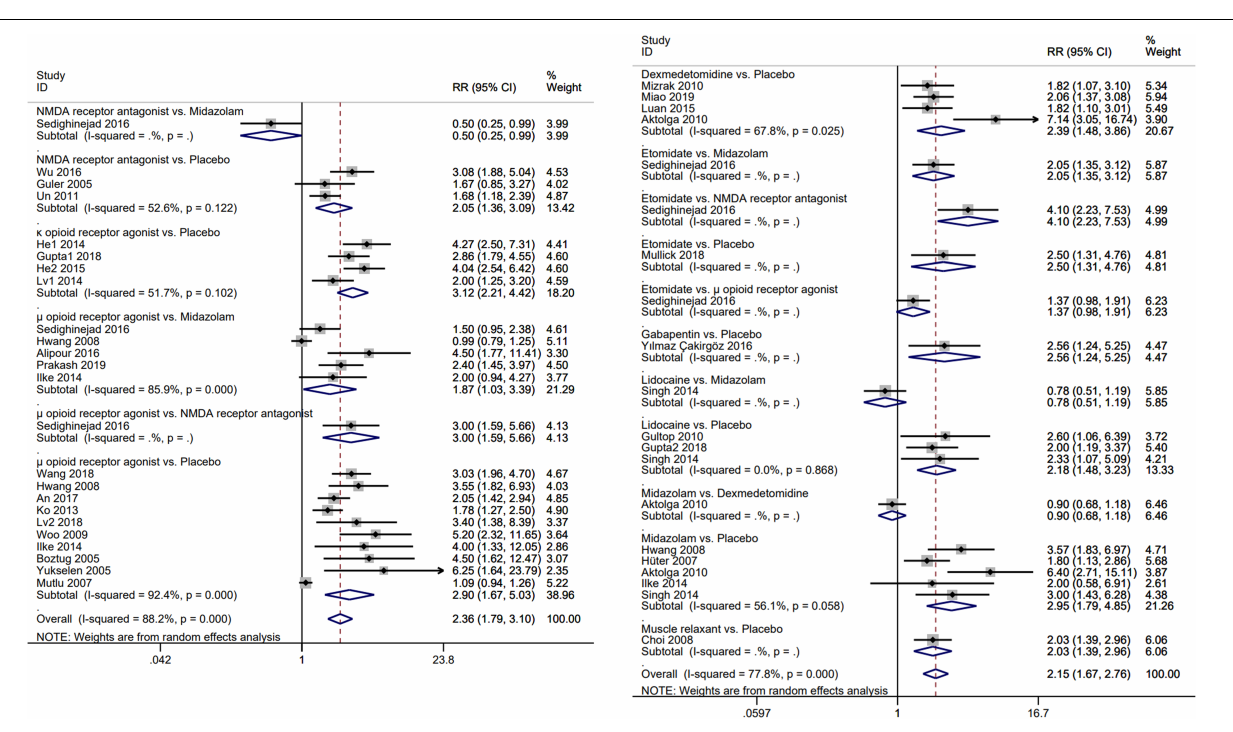
a movement of two different muscles, such as the face, leg, shoulder or elbow, with pronounced tremors. Severe myoclonus is the intense movement or rigidity of two muscles; for